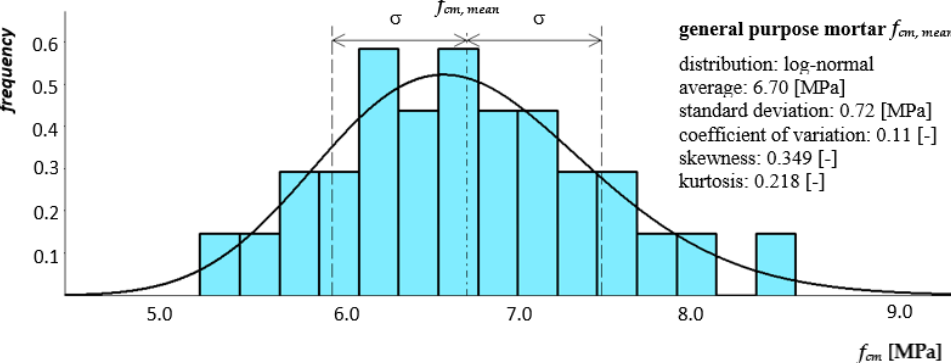
Figure 8. Histogram together with the approximate function of the compression strength distribution of general purpose mortar as a component of a clay brick masonry pillar.